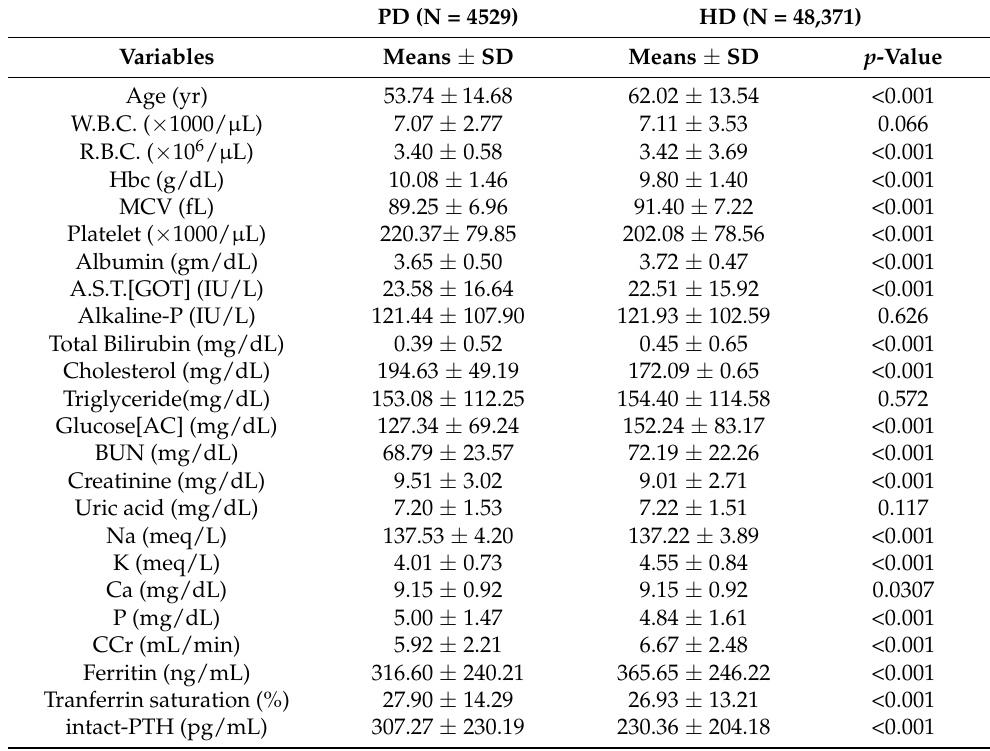
Table 1. Characteristics of the population (N =